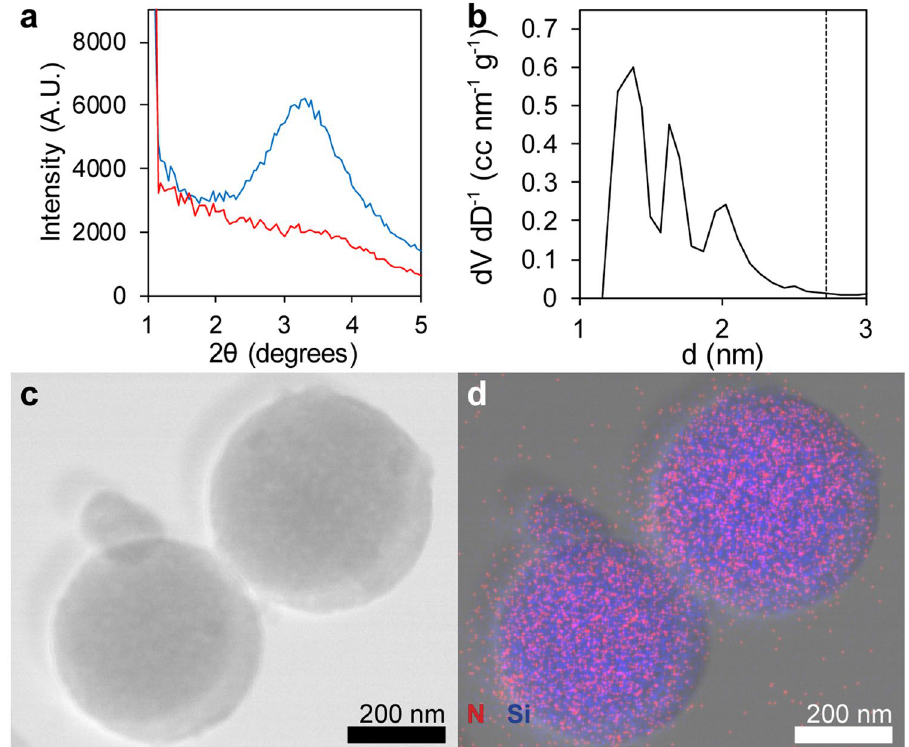
Figure 3. Physical characterization of OCT-MSNs demonstrates the relationship between templating drug molecule and MSN structure. The displayed XRD results ( a ) contain a low, broad diffraction peak typical of as synthesized OCT-templated MSNs (blue), as well as the lack of peak in particles synthesized below the OCT critical micelle concentration (red). DFT analysis ( b ) of N 2 adsorption data shows 3 pore diameters (&#x25AC;) approximately ½ the XRD d-spacing ( ▪▪▪ ). Scanning TEM ( c ) and overlaid EDX map ( d ) of OCT-MSNs confirms the presence of OCT with particles: Si signal emanates from the silica particles, while N (unique to the loaded OCT) signal is confined to the area of